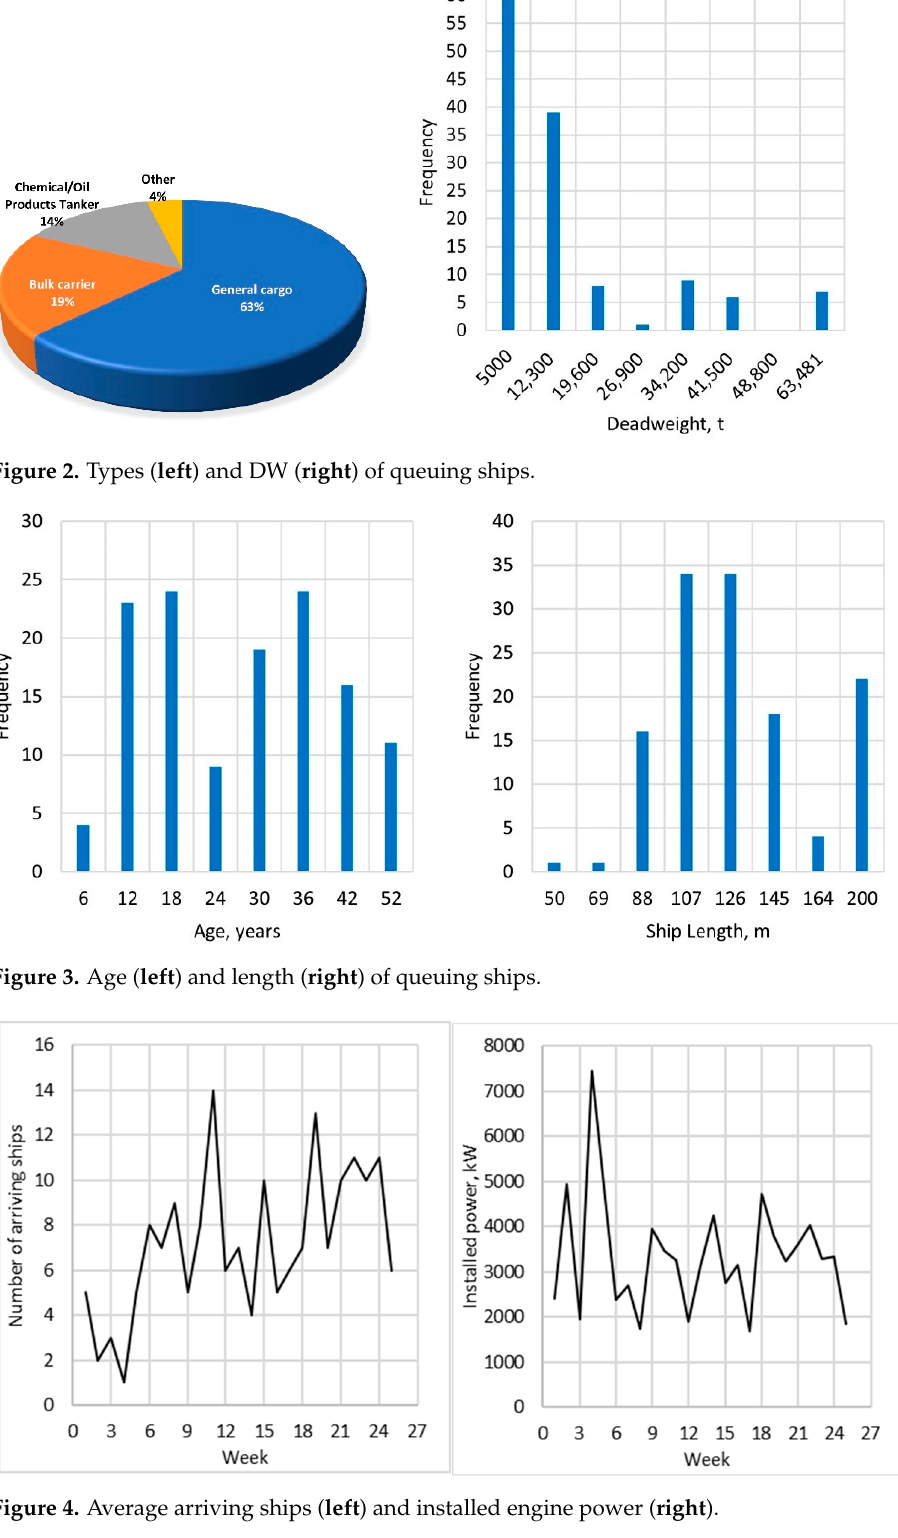
Figure 5. Average queuing time ( left ) and wind speed ( right ). Atmosphere stability is related to resisting or enhancing turbulence, which signifi ‐ cantly affects the concentration of a pollutant. In this respect, the more unstable the at ‐ mosphere is, the more pollutant dilution there is. Stability classes are used for different weather conditions, which are a function of wind speed and solar insolation during the day and cloud cover during the night. Classes A, B, and C stand for volatile, unstable, and slightly unstable conditions, respectively; D stands for a neutral condition; and E and F stand for stable and very stable conditions, respectively. Class G represents the most sta ‐ ble atmosphere possible and is used for the worst ‐ case simulations. Classes of atmos ‐ pheric stability depend on wind speed, as stipulated in [41]. For the region of the Varna seaport, a 25 ‐ week statistic for the winter season is col ‐ lected. The average weekly atmosphere stability is given in Figure 6, right, where the al ‐ phabetic class notation from A to D is presented in a numerical notation, where A = 1, A ‐ B = 2, B = 3, B ‐ C = 4, C = 5, C ‐ D = 6, D = 7, E = 8, F = 9. It can be noticed from Figure 6, right, that the predominant class of stability is D = 7.